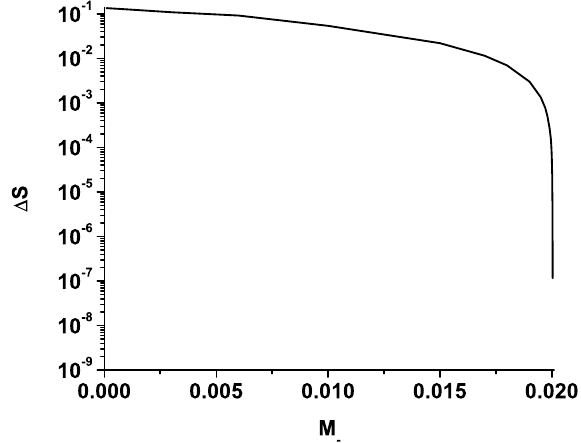
Figure 8 . The change in total entropy of the system as a function of M − in anti de Sitter space. The situation is very similar to de Sitter space, i.e. the entropy is always increasing. As long as M − / M + , ∆ S reduces with M − slowly. The reduction becomes very quick when M − / M + . This implies that the black hole prefers to reduce its energy while triggering the vacuum decay. We set M + = 0 . 02 , Λ + = − 0 . 03 , Λ − = − 3 and G = 1 , and change the black hole rest mass M −